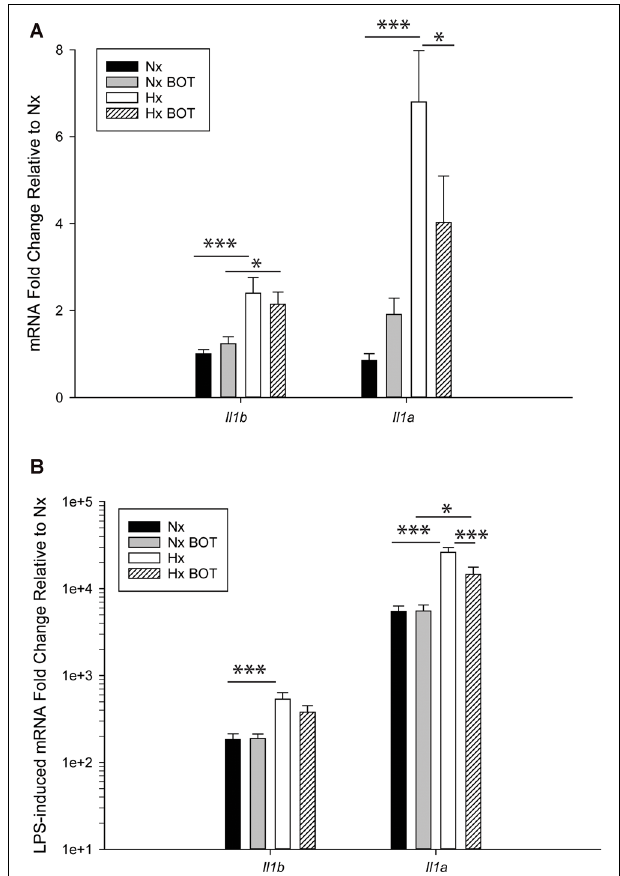
FIGURE 8 | Pharmacologic NF- κ B inhibition attenuates hypoxia-induced inflammatory Il1b and Il1a gene priming. N9 microglia were exposed to Nx or Hx in the presence of a vehicle or the IKK2 inhibitor BOT-64 (3 µ M) after which time the inhibitor was washed out. The fresh medium was replaced, and the cells were challenged with LPS (100 ng/ml) for 3 h. Inflammatory gene expression was evaluated by qRT-PCR. (A) Il1b and Il1a gene expression was evaluated in the presence of BOT-64 treatment during Hx. (B) LPS-induced Il1b and Il1a gene priming were evaluated in the presence of BOT-64 treatment during Hx. Results are presented as the average fold change ± SEM expressed relative to Nx vehicle, of n = 5 independent experiments. All results are displayed as the average fold change ± SEM expressed relative to the WT Nx vehicle of n = 6–7 independent experiments. ∗ p < 0.05, ∗∗∗ p < 0.001; two-way